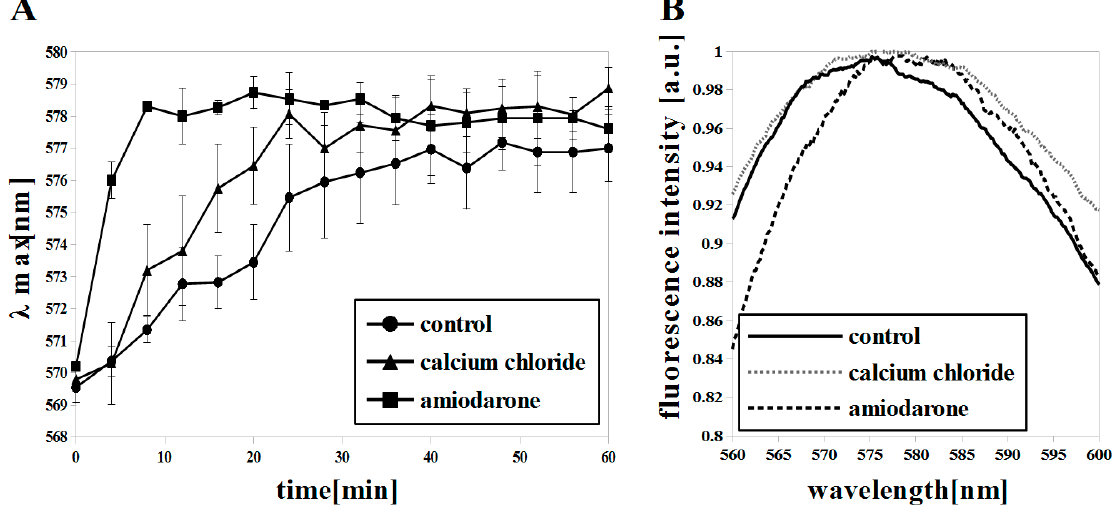
Figure 3. ∆ ψ increase and membrane hyperpolarization in C. albicans induced with calcium chloride (CaCl 2 ) (25 mM) and amiodarone (AMD) (2 μ M) in early log phase (8 h) shown by: ( A ) diS-C 3 (3), means ± SD (n = 4) and ( B ) di-4-ANEPPS (R-B values = 0.978 ± 0.011, 0.996 ± 0.006 and 1.033 ± 0.023 for control, CaCl 2 , AMD, respectively), each spectrum is averaged (n = 9).